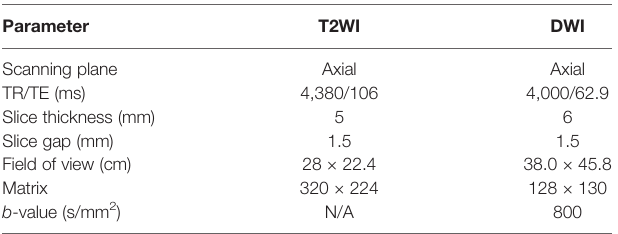
TABLE 1 | Parameters for MRI